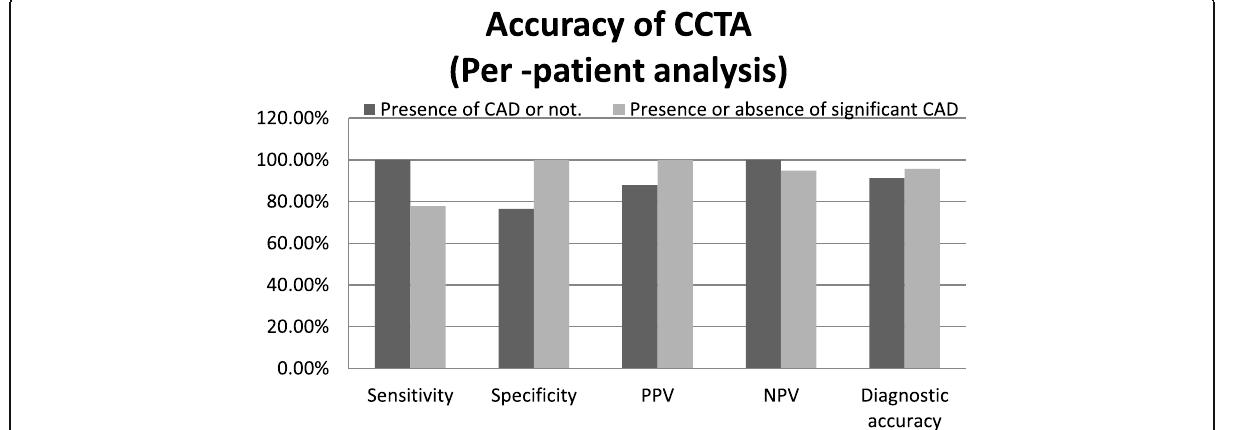
Table 3 Distribution of various degrees of CAD per-vessel analysis among both techniques CCTA CAG Normal or no significant stenosis